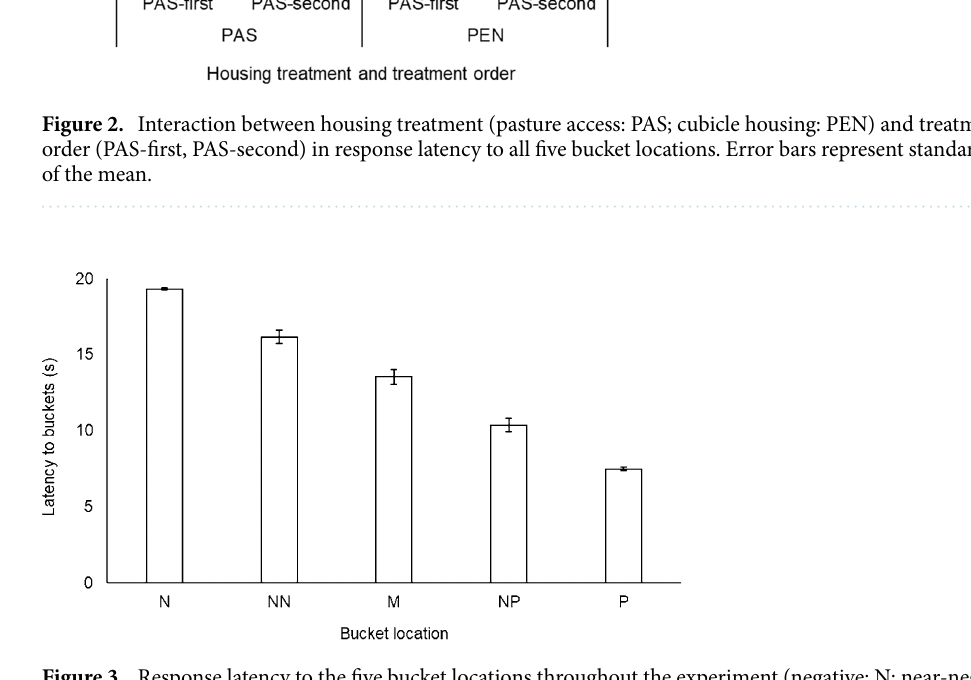
Figure 3. Response latency to the five bucket locations throughout the experiment (negative: N; near-negative: NN; middle: M; near-positive: NP; positive: P). Error bars represent standard error of the mean.